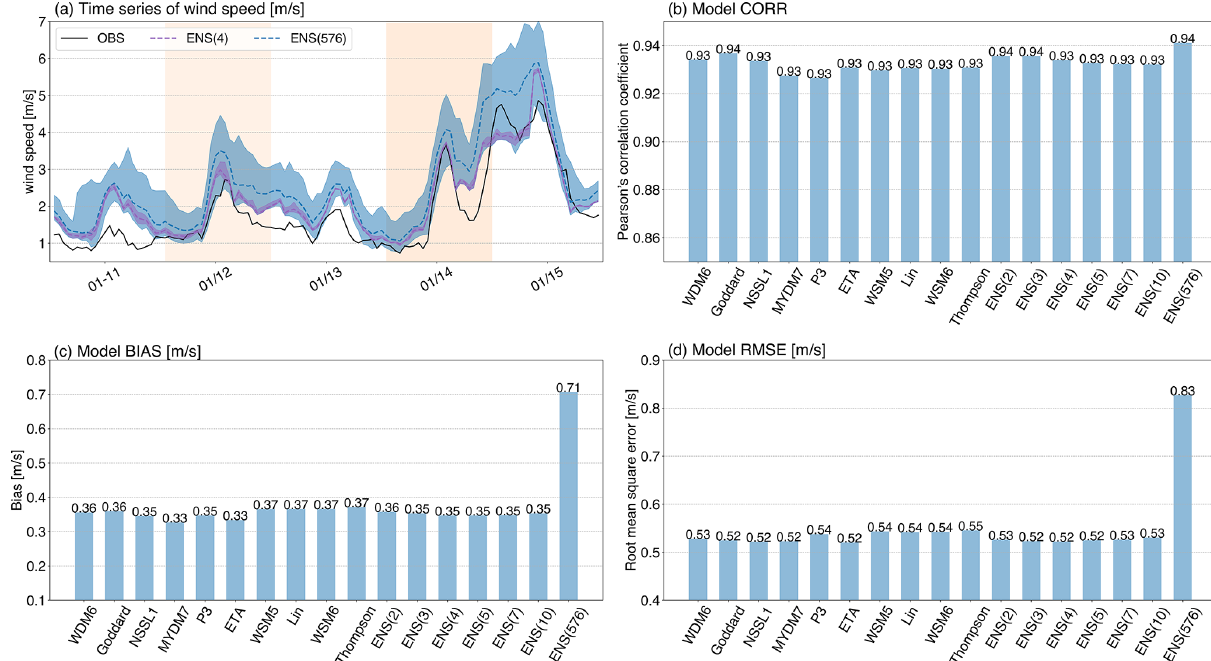
Figure 10. (a) Time series of wind speed (ms − 1 ) from observation and different ensembles, and (b) CORR, (c) BIAS and (d) RMSE scores for the best 10 simulations along with different ensembles. The shadings in (a) represent the spread for ENS(4) and ENS(576). As the best 10 simulations use the same PBL (YSU) and SW–LW (Dudhia–RRTM) schemes, only the MP schemes are labeled in the